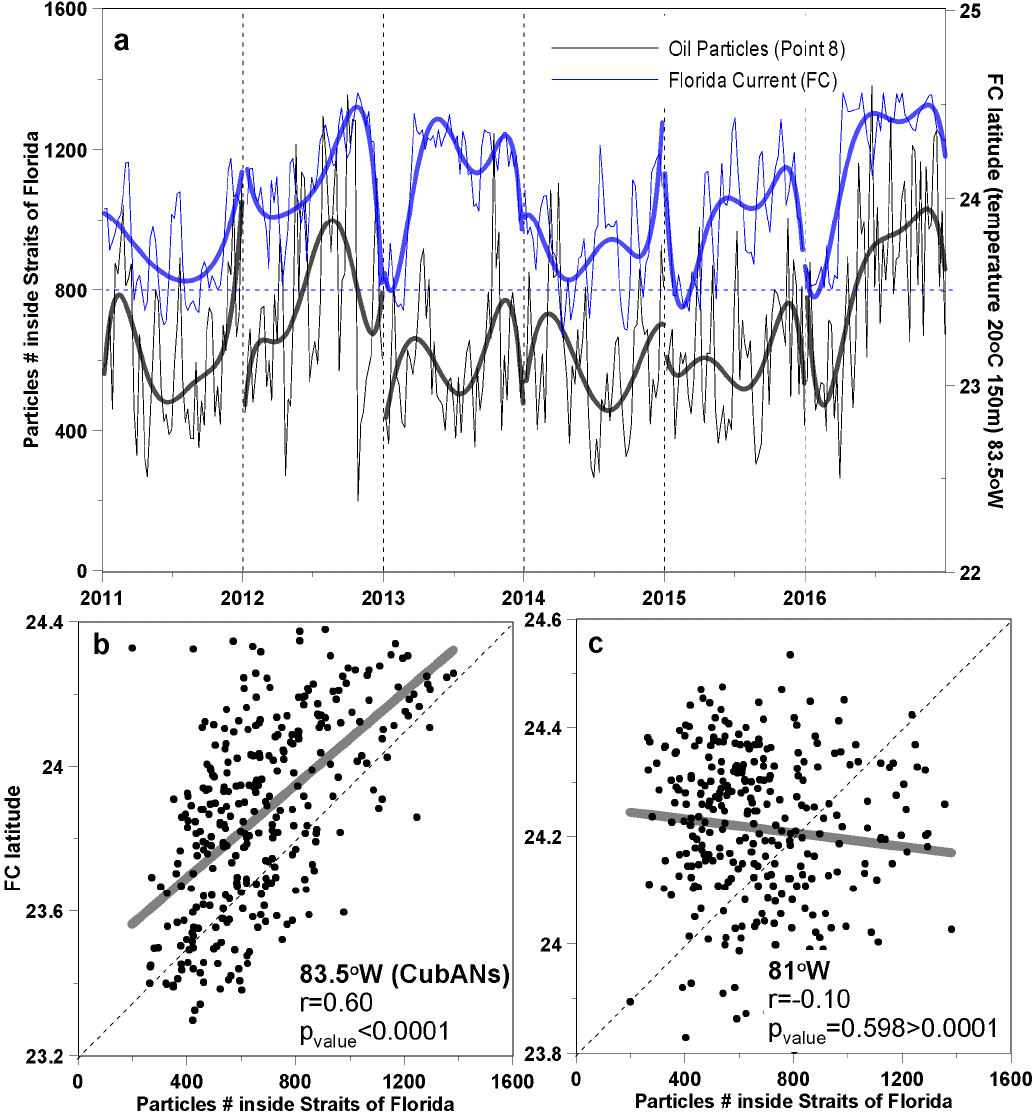
Figure 12. ( a ) Time series of weekly number of oil elements (black line) that were released at Point 8 and computed inside the Straits of Florida (dashed box in Figure 1b) overlaid with the respective Florida Current (FC) latitude, derived as the location of the 20 °C temperature contour line at 150 m along 83.5° W (Section S1). The respective annual polynomial fit (5th order) for each time series is indicated with a solid line. Scatter diagrams between the element number and the FC latitude are shown along ( b ) 83.5° W (Section S1) and ( c ) 81° W (Section S2) meridians. The linear fits (thick grey line), the Pearson correlation coefficients r, and the p value are also presented in ( b , c ). See Figure 1a for the positions of Sections S1 and S2 and Figure 1b for the position of Point 8.